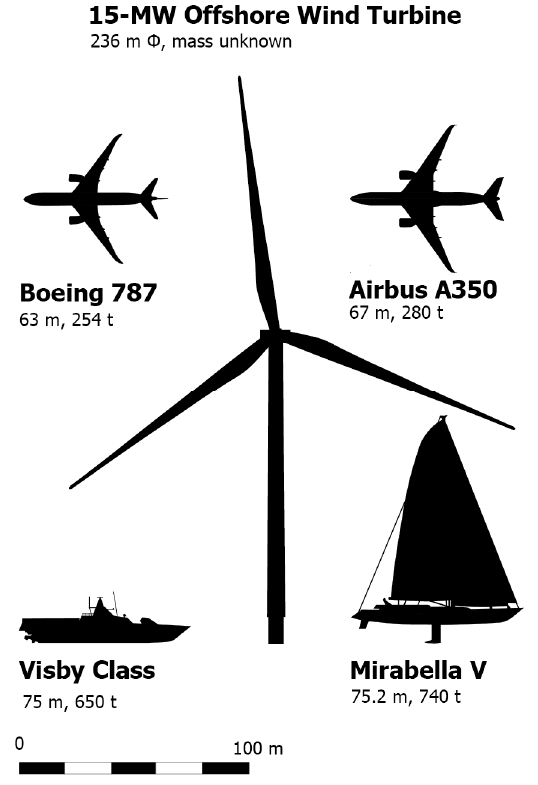
Figure 1. Large composite structures drawn to scale (a) Boeing 787 Dreamliner, (b) Airbus A350XWB, (c) Vestas V236 wind turbine with 115.5 m blades, (d) HSwMS Visby, (e) Mirabella V.